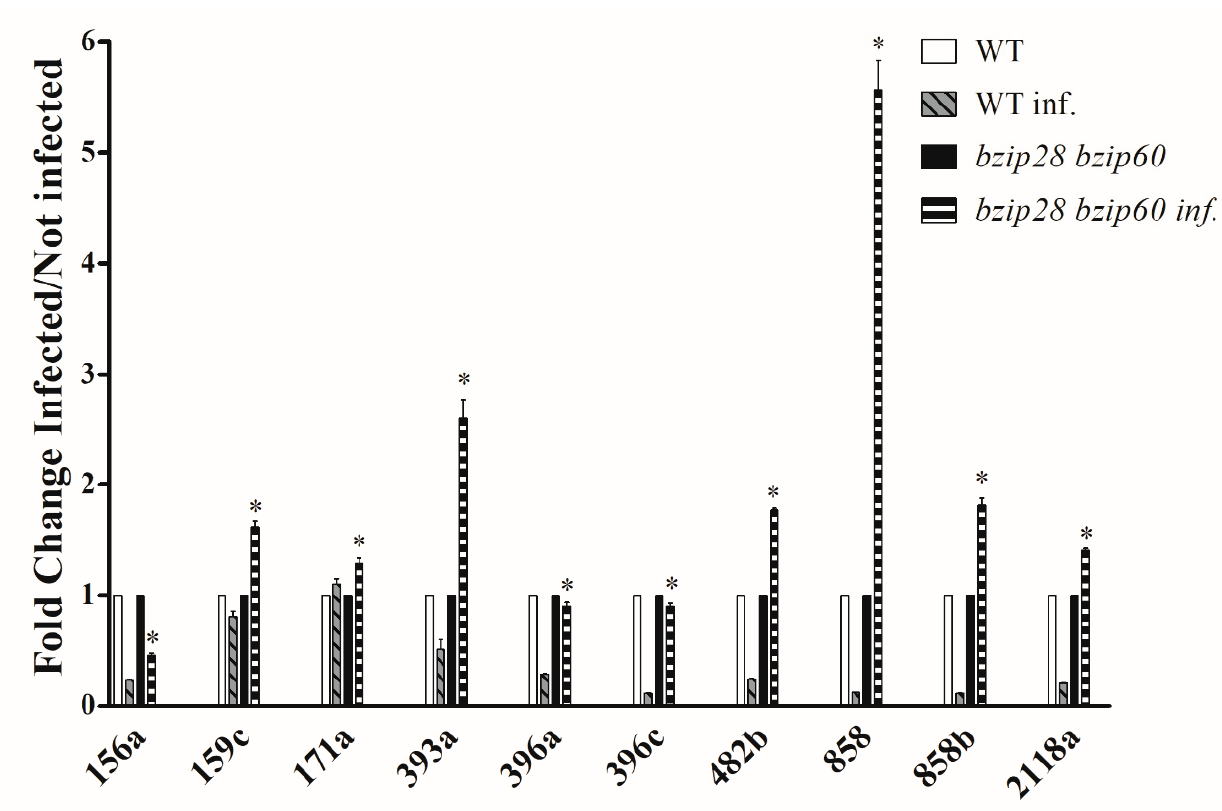
Figure 9. miRNA expression in leaves from WT and bzip28 bzip68 mutant Arabidopsis plants infected by D . gigantea for 24 h. Accumulation of 156a, 159c, 171a, 393a, 396a, 396c, 482b, 858, 858b and 2118a miRNAs was determined by qRT-PCR in leaves from WT and bzip28 bzip60 mutant Arabidopsis plants infected with a suspension of D . gigantea conidia (500,000/mL). After 24 h, leaves were collected and subjected to miRNA analysis as reported in Section 2.2. Values represent the mean values ± SD of independent measurements ( n = 4). The results of the infected plants were reported as fold changes values with respect to the corresponding non-infected samples considered as unit (WT inf vs. WT; bzip28 bzip60 inf vs. bzip28 bzip60 ). Statistical significance was attributed by one-way ANOVA test (* p <